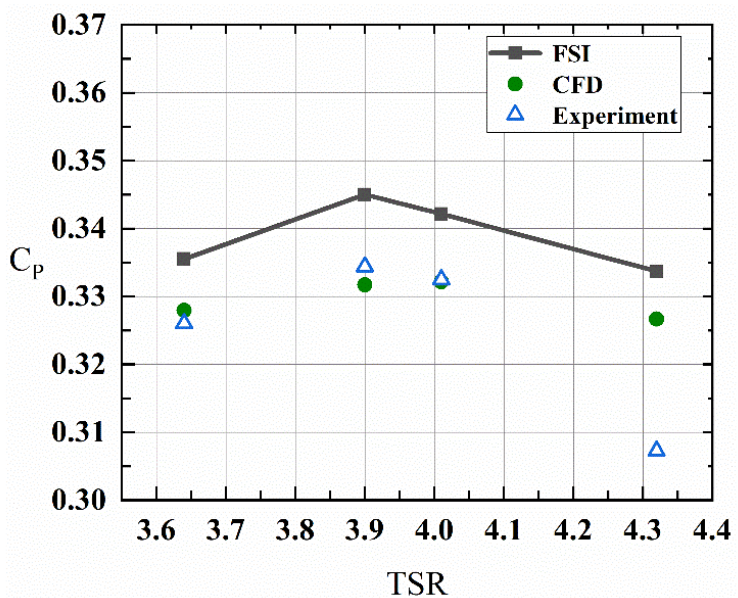
8 of 16 Figure 5. Layout of circulation pool and turbine.